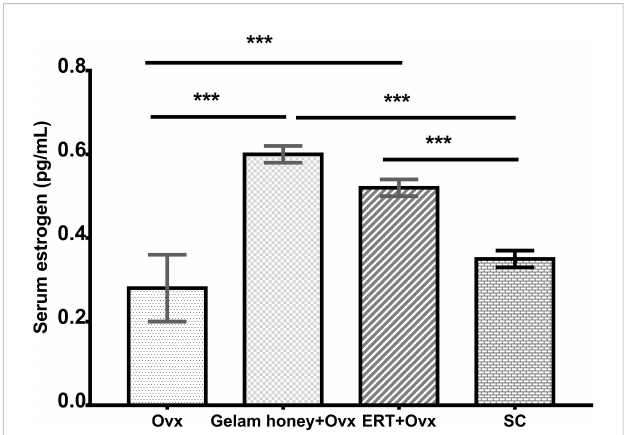
FIGURE 2 Effect of Gelam honey on estrogen serum levels (pg/mL) in menopause rats. Estrogen serum levels were measured using a competitive enzyme-linked immunosorbent assay (ELISA). All values represent the mean ± SEM, p<0.05. Gelam honey +Ovx: Gelam honey and bilateral oophorectomized group. ERT+Ovx: Estrogen replacement therapy and bilateral oophorectomized group. Ovx: Bilateral oophorectomized group. SC: Sham